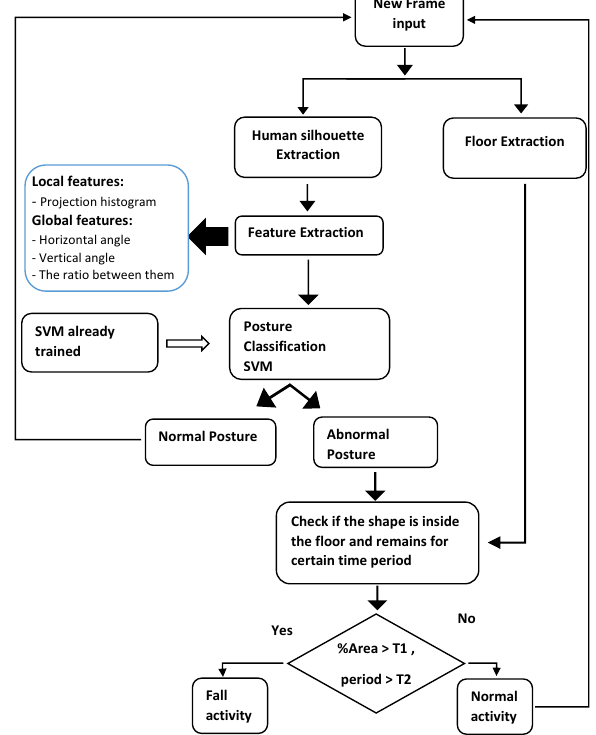
Figure 1. Main component of the fall detection